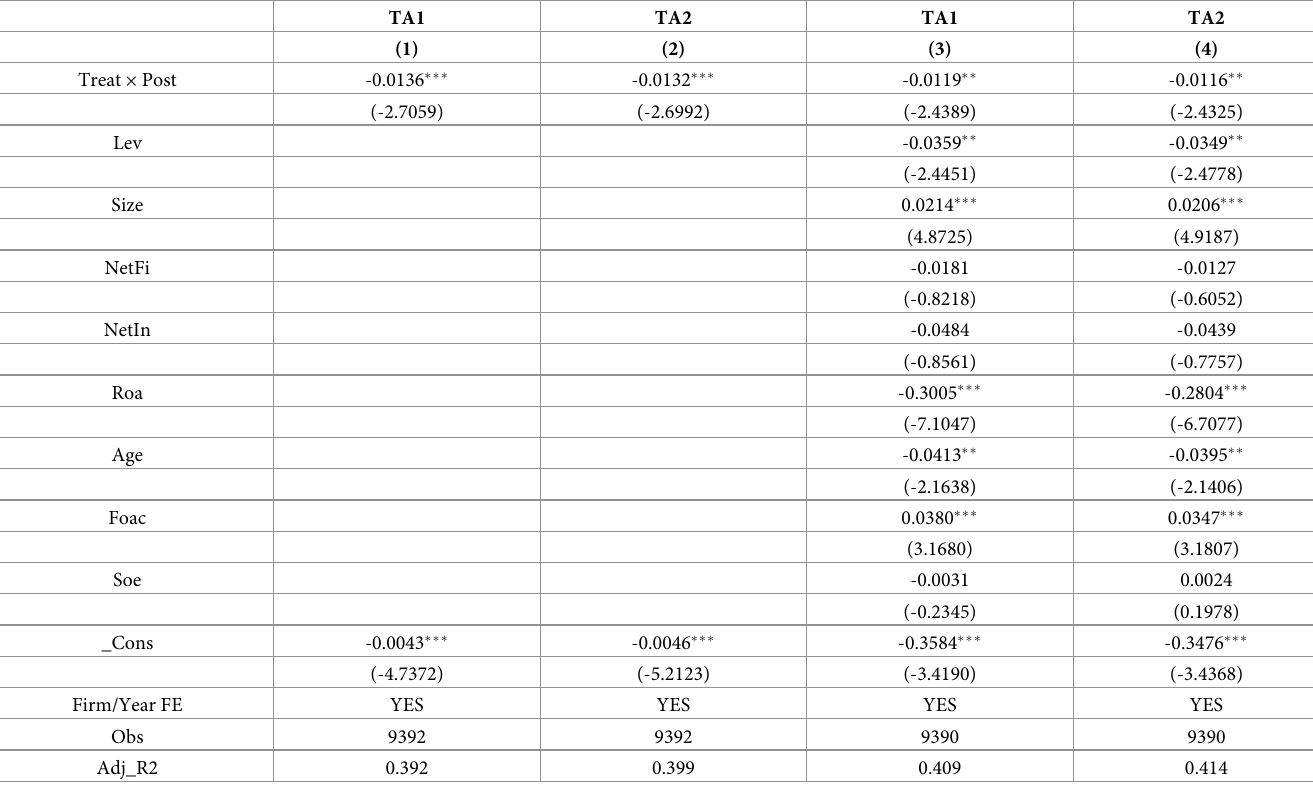
Table 2. Environmental regulation and corporate tax